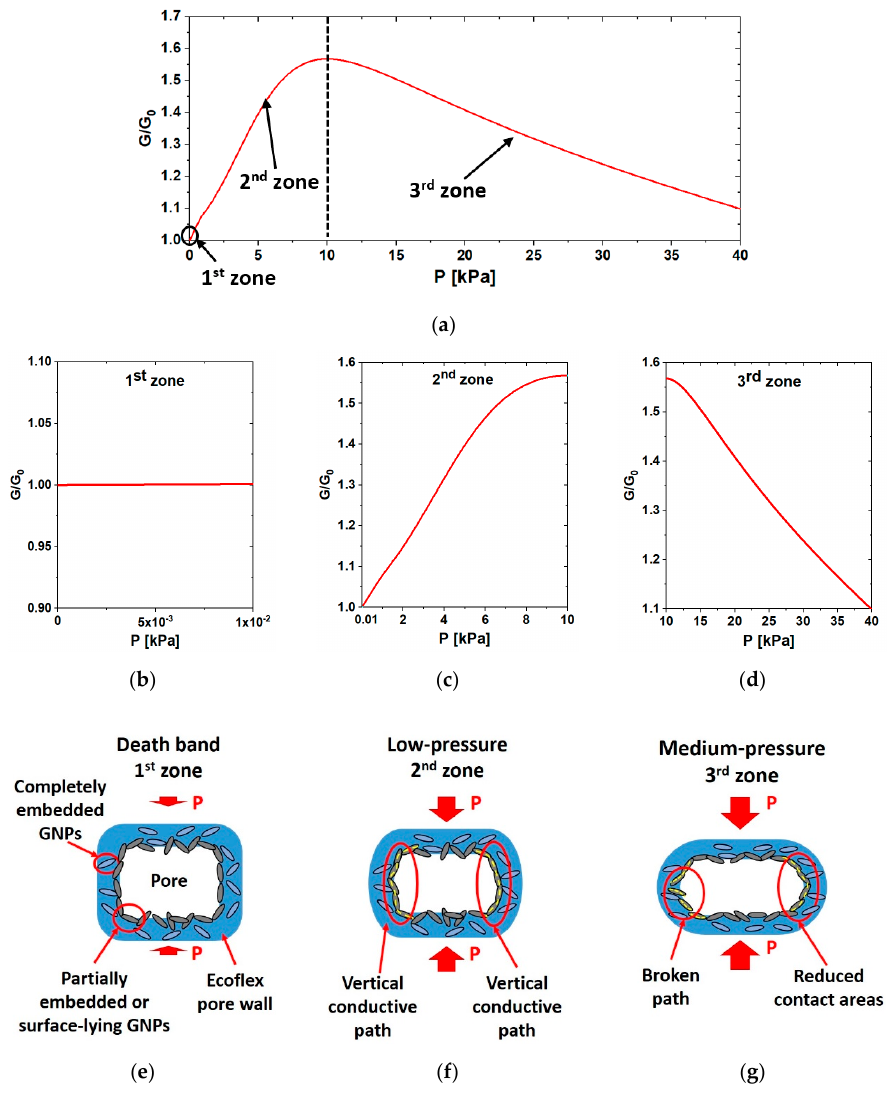
Figure 14. GNP coating modification during compression and its effect on the overall normalized conductance G/G 0 of the foam. ( a ) Normalized conductance vs. pressure for the EFT-3% sample. ( b – d ) Zoom of the death-band zone (1 st zone) and the low- (2 nd zone) and medium- (3 rd zone) pressure ranges of the sensor, respectively. ( e – g ) Sketch of the effects of different pressure values on the EFT-3% pore and on the induced modification of GNP percolation paths. In particular, in the sketch, the light blue GNPs represent the completely embedded flakes, while the grey ones represent the partially embedded or surface-lying GNPs.